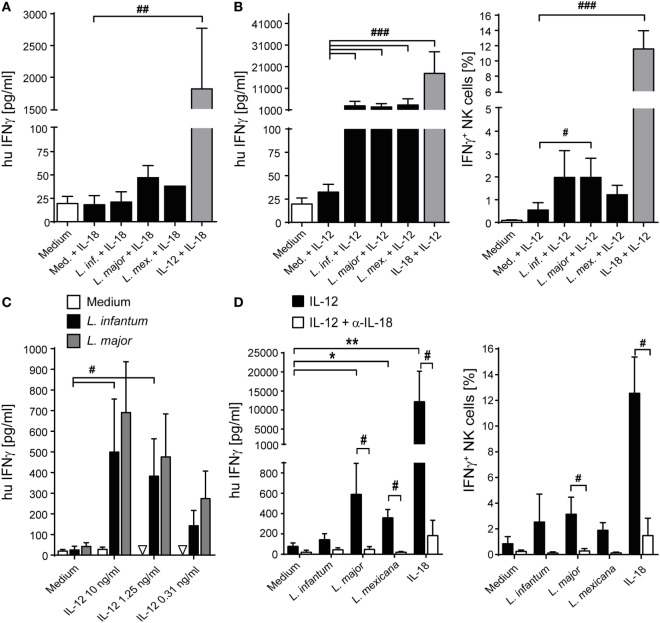
Effect of exogenous interleukin (IL)-12 and IL-18 on interferon (IFN)-γ production of natural killer (NK) cells in peripheral blood mononuclear cell (PBMC)-Leishmania cocultures. Human PBMCs were cocultured with Leishmania spp. promastigotes (multiplicity of infection 10) in presence or absence of exogenous IL-12 and/or IL-18 (10 ng/ml each, or as indicated) and neutralizing IL-18 antibody (1.5 µg/ml) for 20 h. Thereafter, IFN-γ production was measured either by ELISA of cell culture supernatants [(A,B) (left graph), (C,D) (left graph)] or by flow cytometry of intracellular IFN-γ in NKp46+CD3− NK cells [(B) (right graph), (D) (right graph)]. Values below detection limit are marked by triangles. (A) Mean ± SEM of 6/6/6/3/1/6 donors for the six stimulations. (B) Mean ± SEM of 22/22/22/21/18/22 (ELISA, left panel) or 9 (ICS, right panel) donors. (C) Mean ± SEM of 6/6/3 donors for the three stimulations (medium, Leishmania infantum, and Leishmania major). (D) Mean ± SEM of six (ELISA, left panel) or five (ICS, right panel) donors. *,#p < 0.05, **,##p < 0.01, ###p < 0.001 two-tailed Mann–Whitney U test.